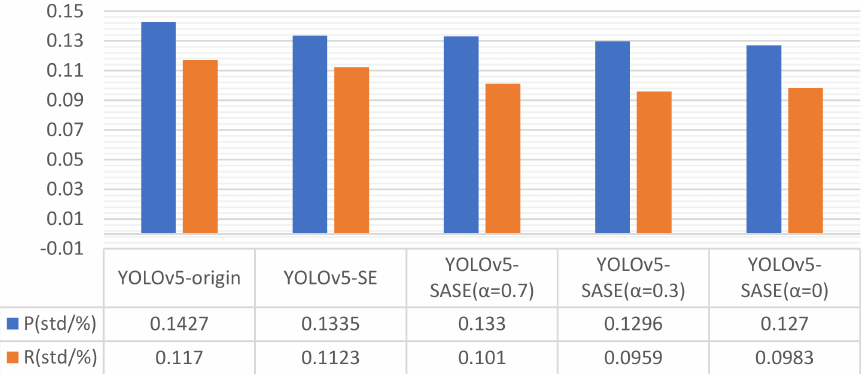
Figure 12. Stability comparison experiment of SASE module training results. Standard deviation is taken from the last 50 data in 200 epochs.